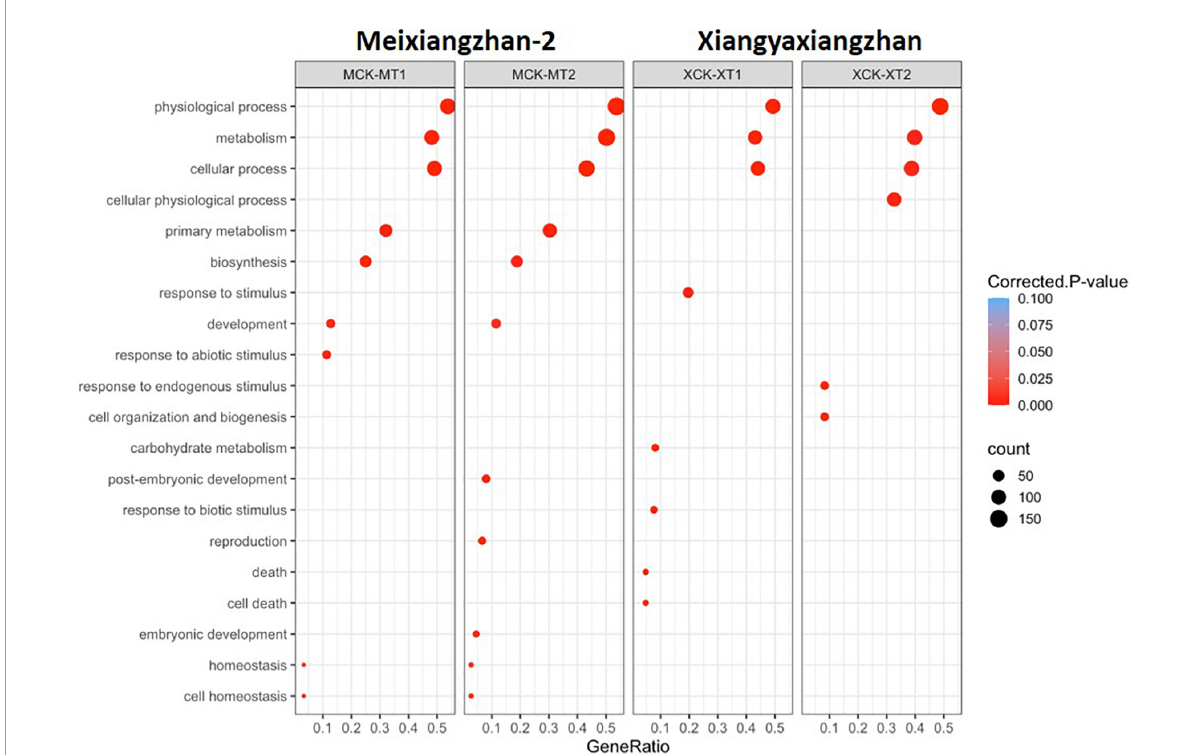
FIGURE3 GO classification of differentially alternative spliced (DAS) events in Meixiangzhan-2 (M) and Xiangyaxiangzhan (X) cultivars in response to different levels of Zn treatment. Colors indicate the P -values from Fisher’s exact test, and dot size is proportional to the number of genes (the genes that exhibited DAS events) in the given